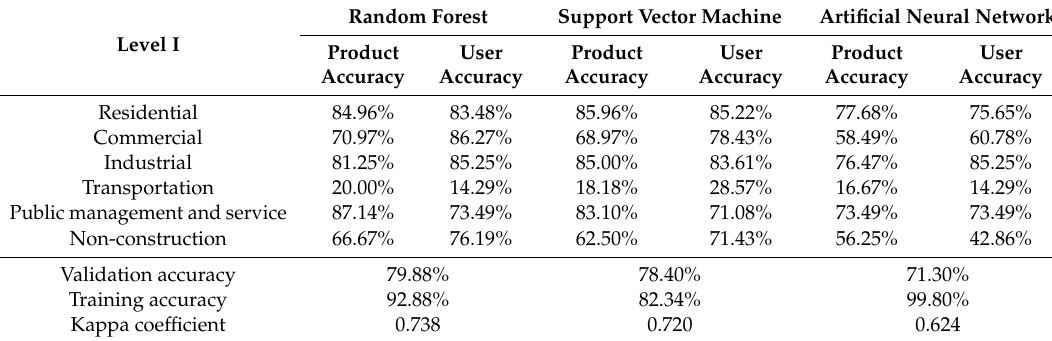
Table 3. Accuracy comparison of the Level I land-use classification.